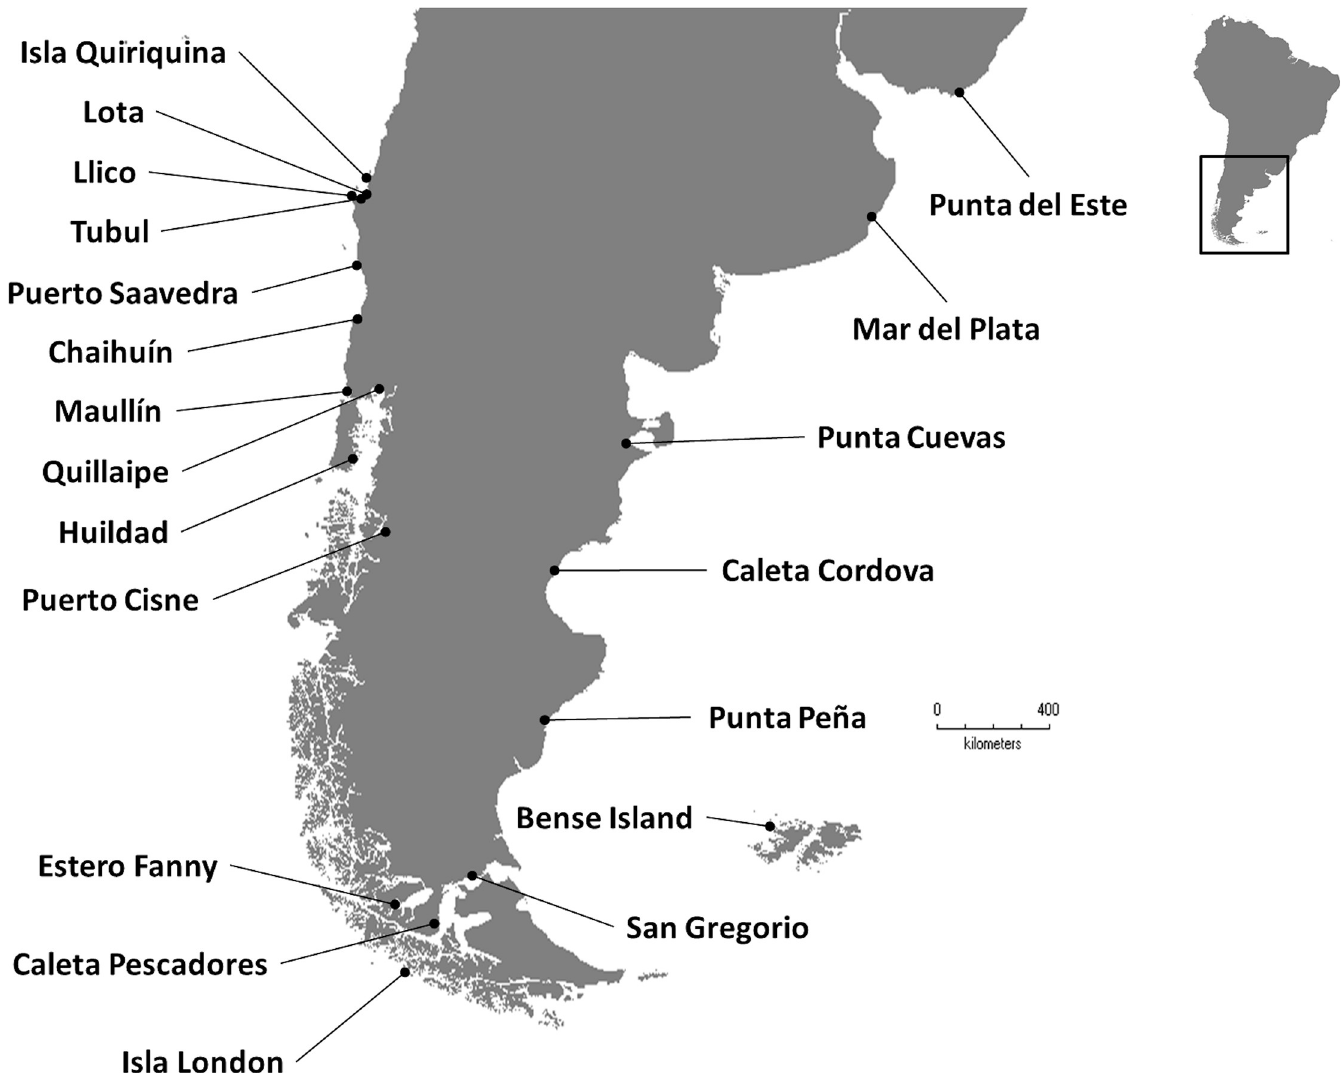
Fig 1. Map of the collection sites of smooth-shelled blue mussels ( Mytilus spp.) in South America, including Chile, Argentina, the Falkland Islands and